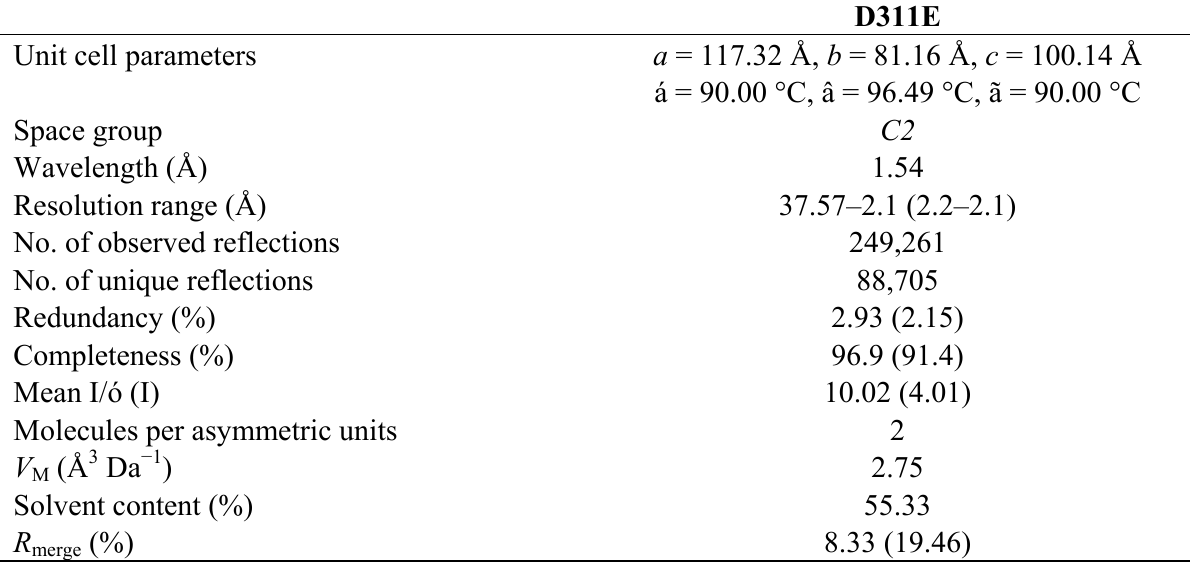
Table 4. Summary of the crystallographic